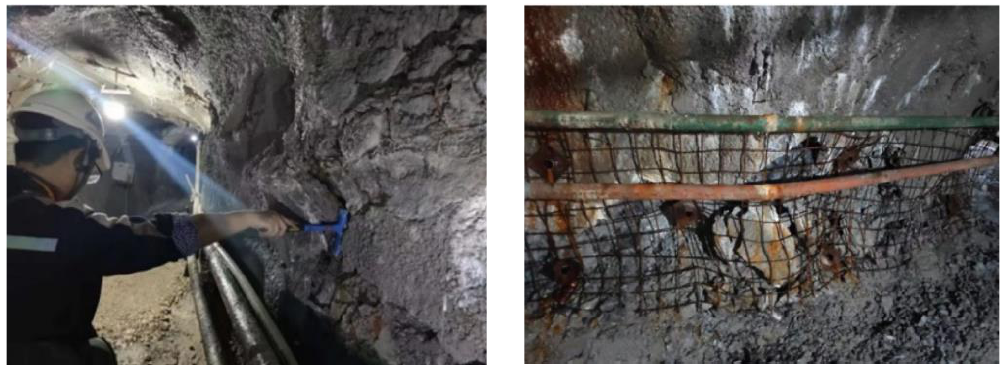
Figure 9. Deformation damage of quasi-ramp support in I-8# orebody.